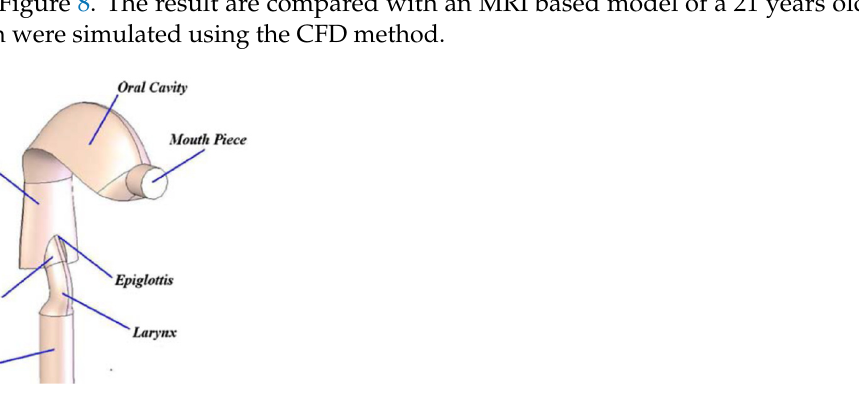
10 of 17 Figure 7. PIV experimental setup Reprinted with permission from Ref. [45] . 2003, A. F. Heenan et